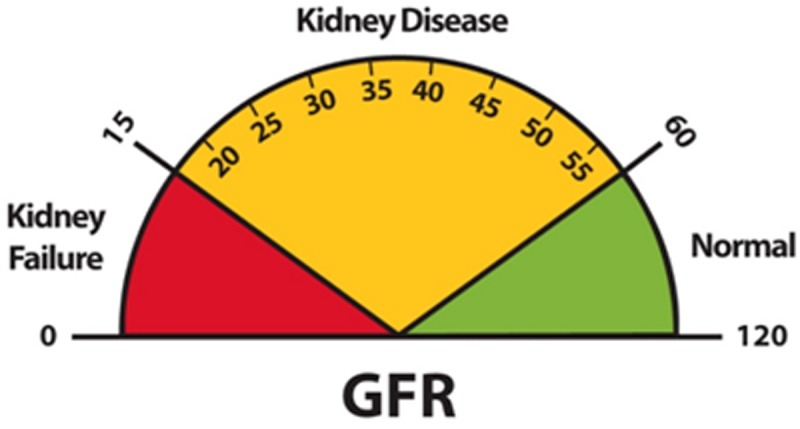
Kidney function chart [27].